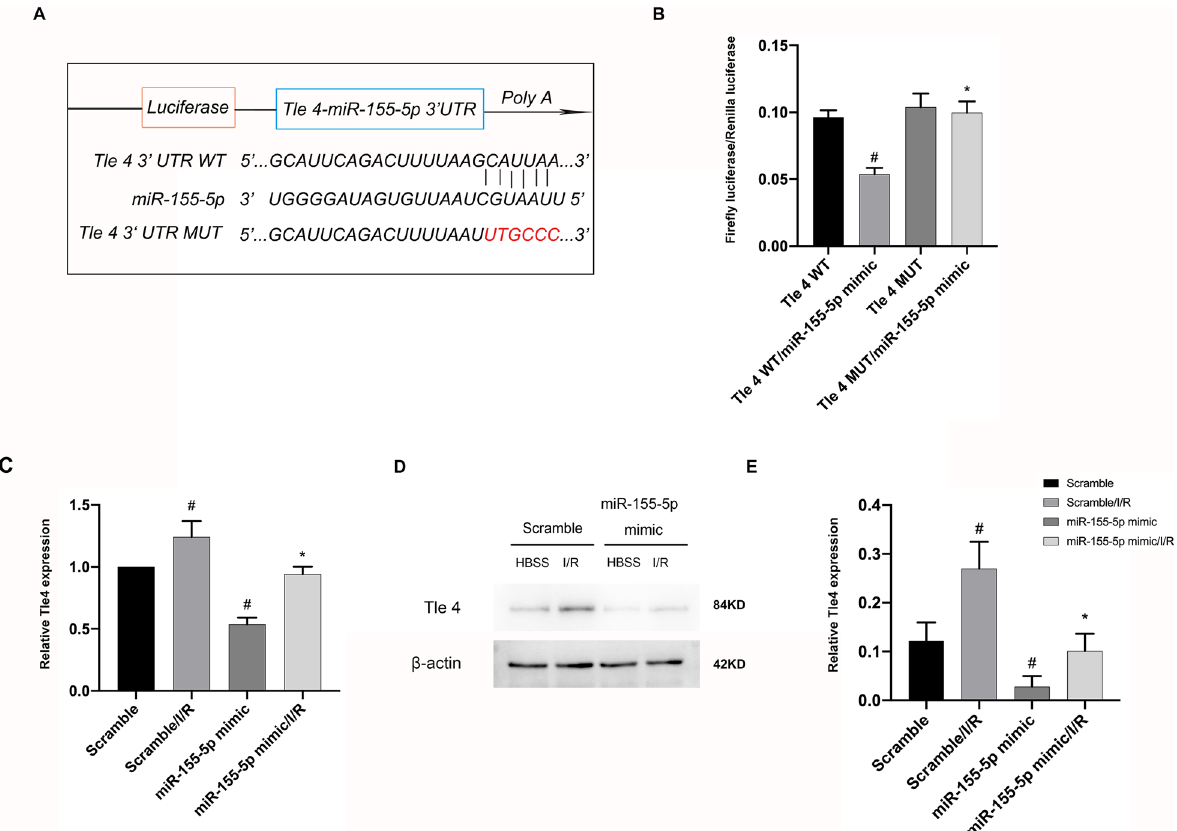
Fig. 6 Tle4 is a putative target of miR-155-5p. RGCs were transfected with 50 nM miR-155-5p mimic, Tle4 siRNA, or scramble before I/R of 2/2 h. A The putative target site for miR-155-5p within the 3 ′ -UTR of mouse Tle4. B Detection of luciferase activity after co-transfection with 3 ′ -UTR luciferase reporter vector for mouse Tle4-WT, Tle4-MUT, and miR-155-5p mimic. C , D RT-qPCR and Western blot analysis of Tle4 and β-actin. E Densitometric analysis of immunoblot bands. Data are expressed as mean SD (n 6). # p < 0.05, scramble with I/R group or miR-155-5p mimic group versus ± = scramble group, Tle4 WT/miR-155-5p mimic group versus Tle4 WT group; * p < 0.05 , the miR-155-5p mimic group with I/R group versus scramble with I/R group, Tle4 MUT/miR-155-5p mimic group versus Tle4 WT/miR-155-5p mimic